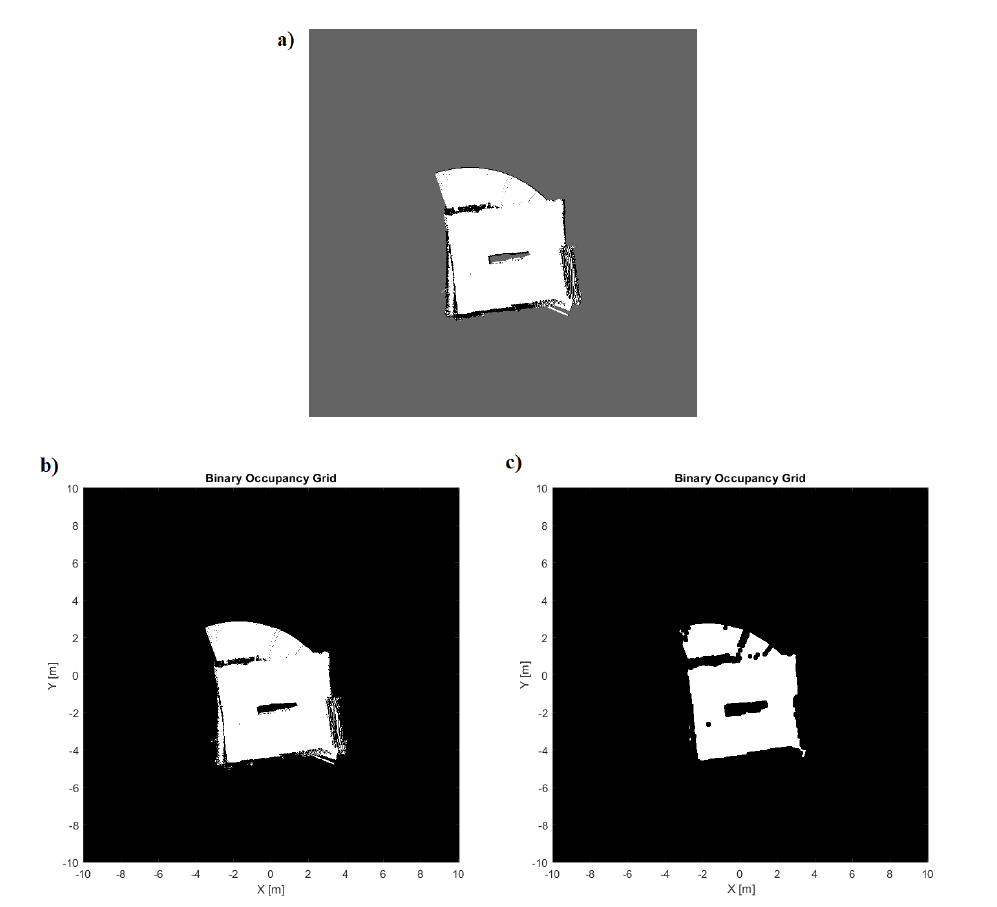
Figure 6. Stages of creating a grid of obstacles. In subfigure ( a ) shows the generated occupancy grid. In subfigure ( b ) shown is declared coordinate grid. In subfigure ( c ). shows robot motion trajectory